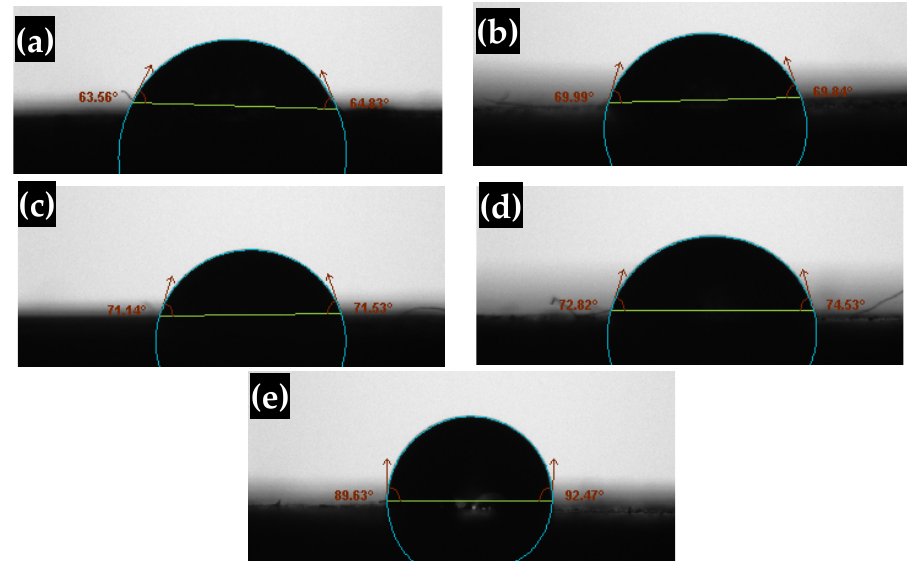
Figure 6. Photographs of water contact angle on the surface of ( a ) pure acrylic polymer, and acrylic